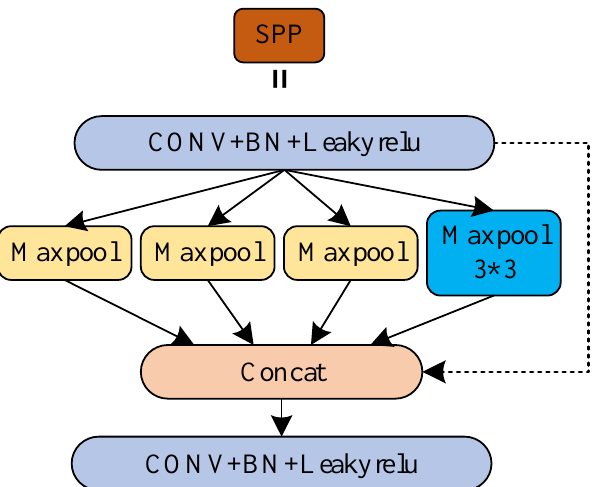
Figure 6. The network structure of improved SPP module.